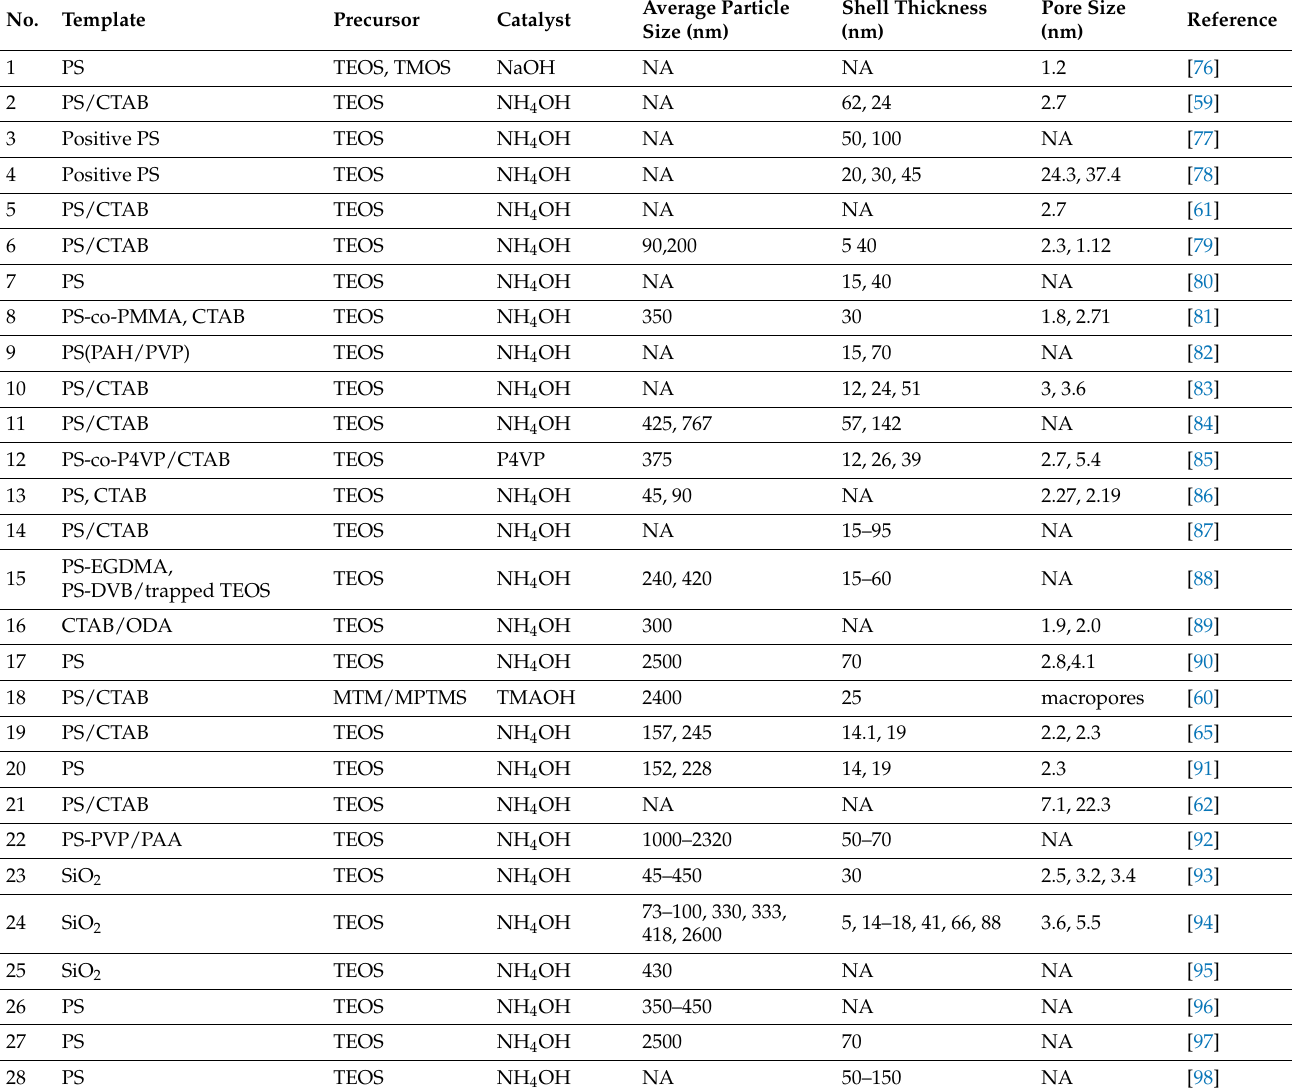
Table 2. List of hollow silica spheres with the average diameter, shell thickness, and pore